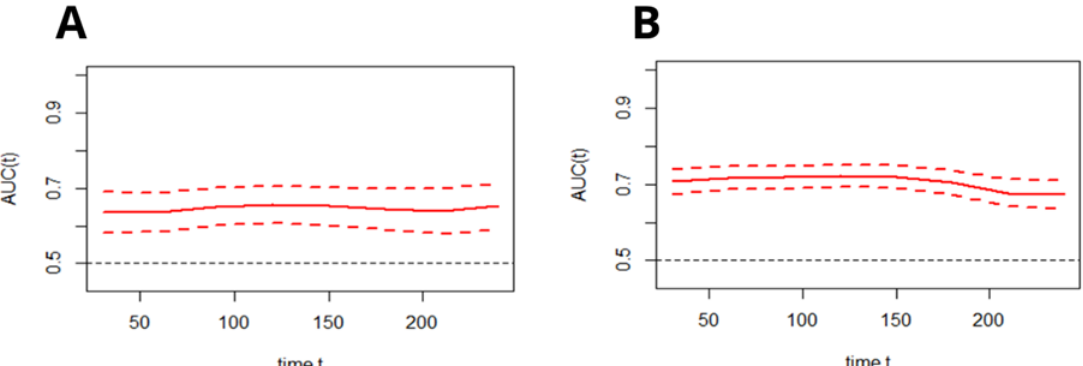
Figure 2. Time-dependent ROC analysis for the C 2 HEST predictive abilities of all-cause death in the diabetic ( A ) and non-diabetic ( B ) cohorts (mean with CI). AUC—area under curve.